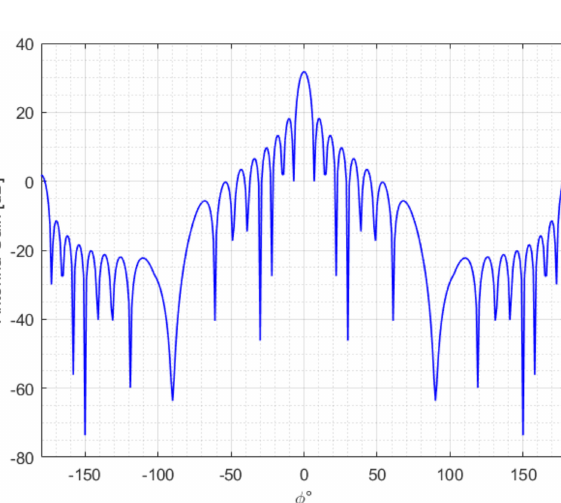
Figure 1. 2D slice of the 3D antenna pattern realization of the 3GPP active antenna array model with 256 antenna elements directed perpendicularly to the antenna array over the steering angles in the azimuth and